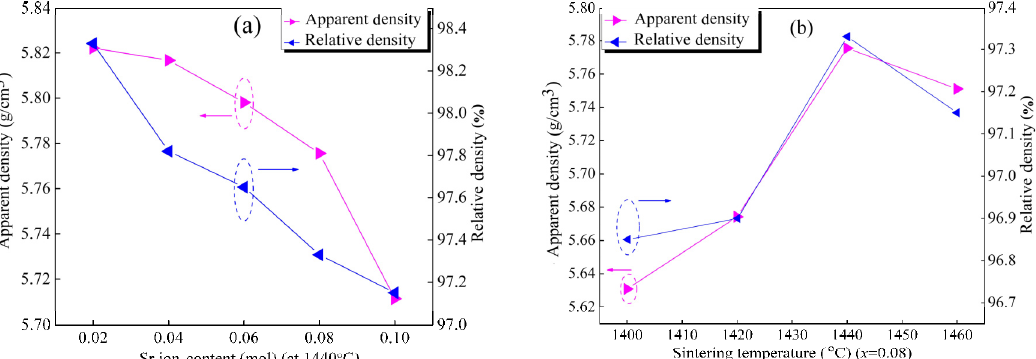
Fig. 6 (a) Influence of the apparent density and relative density of the (Ba 1 − x Sr x ) 4 (Sm 0.4 Nd 0.6 ) 28/3 Ti 18 O 54 ceramics on the amount of Sr 2+ ions; (b) influence of the apparent density and relative density of the (Ba 1 − x Sr x ) 4 (Sm 0.4 Nd 0.6 ) 28/3 Ti 18 O 54 ( x = 0.08) ceramic at different sintering temperatures.